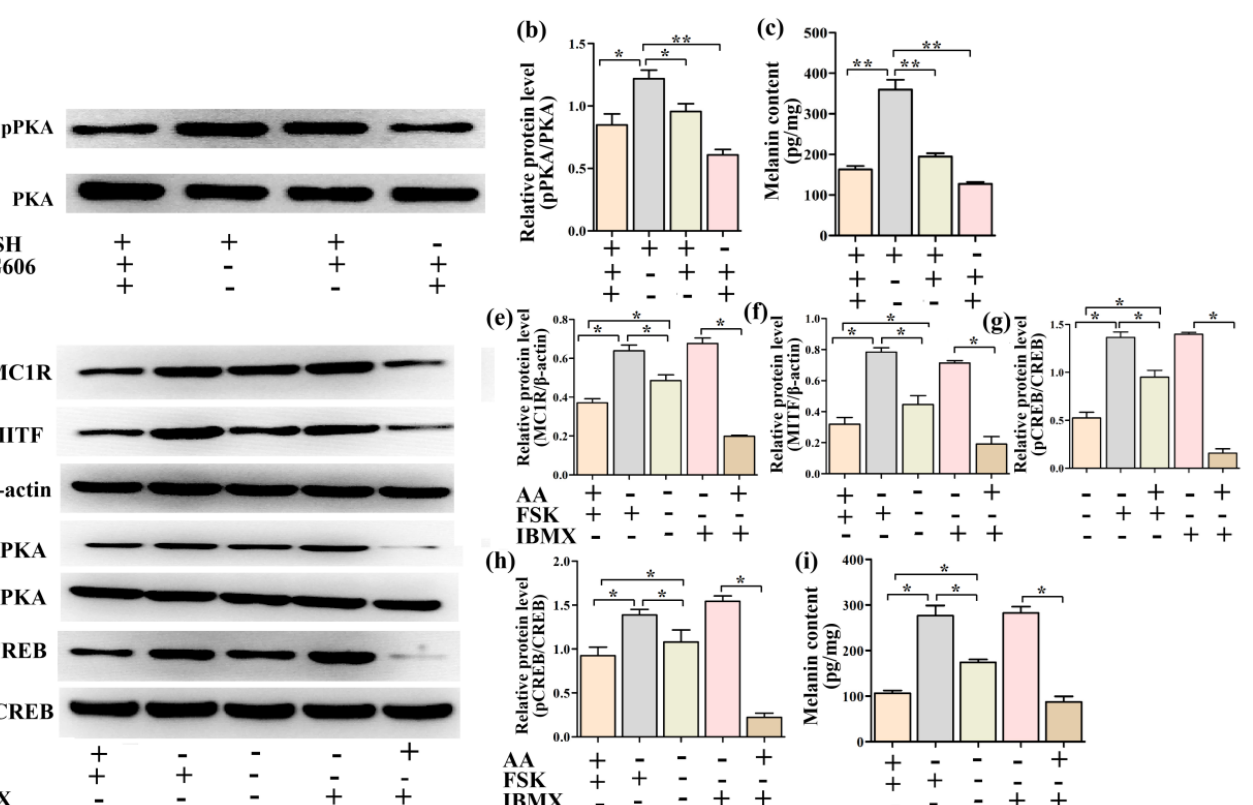
Figure 8. Effects of AA and MSG606 9 (MC1R inhibitor) on the protein expression levels of pPKA ( a , b , c ) and melanin content ( d ) in α -MSH-induced PIG1 cells for 24 h. Effects of AA on the protein expression levels of MC1R, MITF, pPKA and pCREB ( e , f , g , h ) and melanin content ( i ) in FSK- or IBMX-induced PIG1 cells for 24 h.Data are expressed as mean ± SEM. * p < 0.05, ** p < 0.01. ( n = 3 per group).